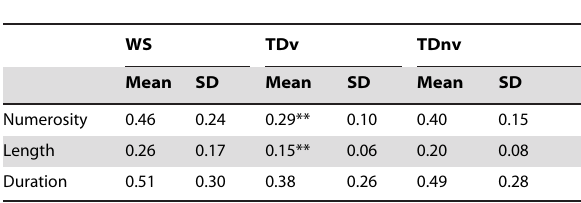
Table 4. Weber Fraction by Task and by